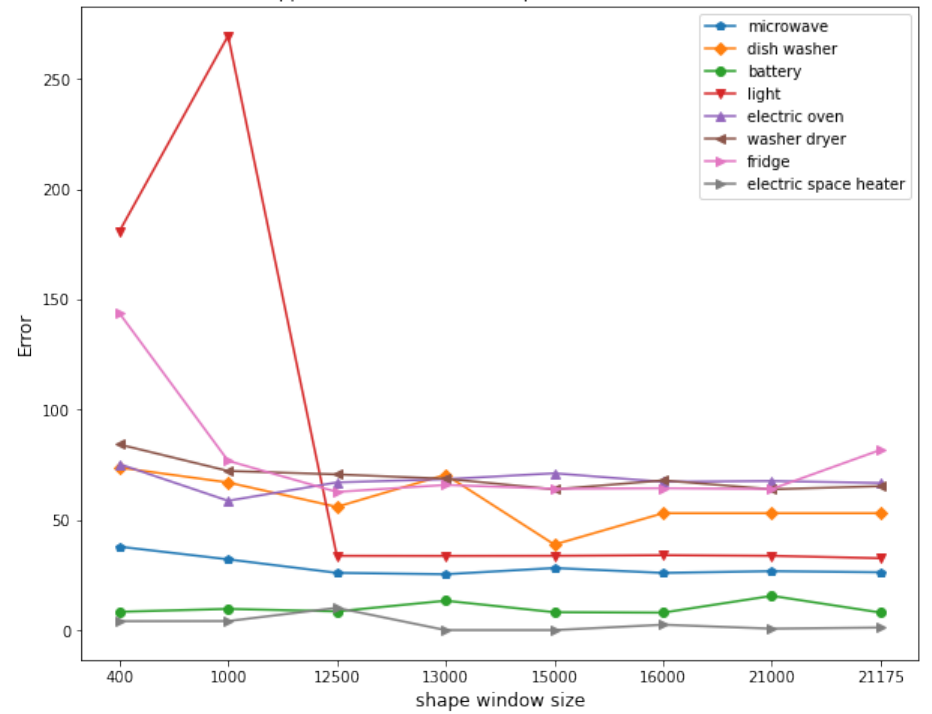
Figure 6. Error change of microwave with shape window size in the REDD